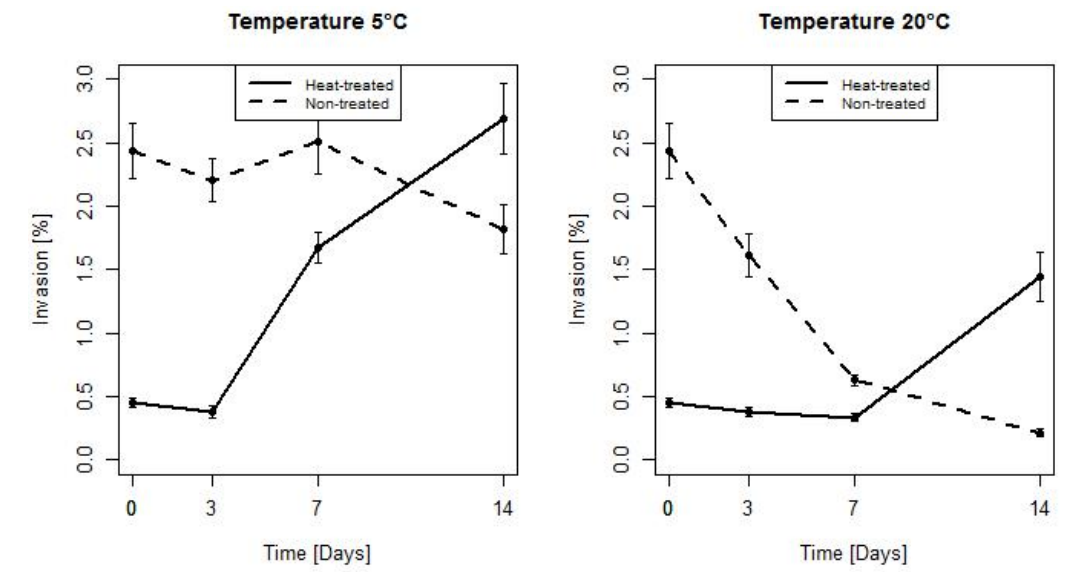
Figure 8. The changes of the invasiveness of HT and NT bacteria stored at 5 and 20 °C (error bars represent standard errors of the mean).